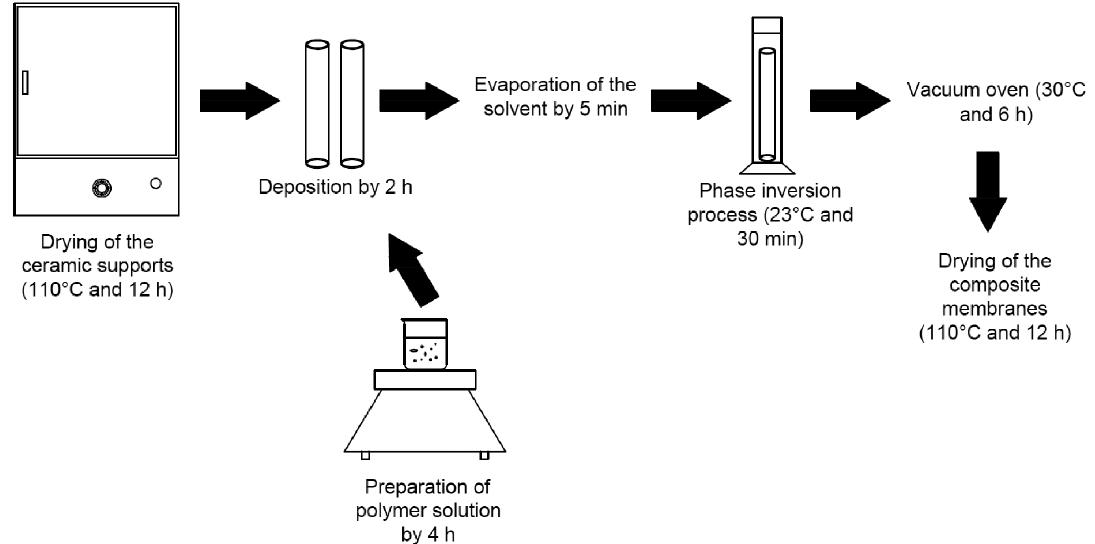
Figure 1. Experimental methodology used in obtaining of the composite membranes PA-1 and PA2.